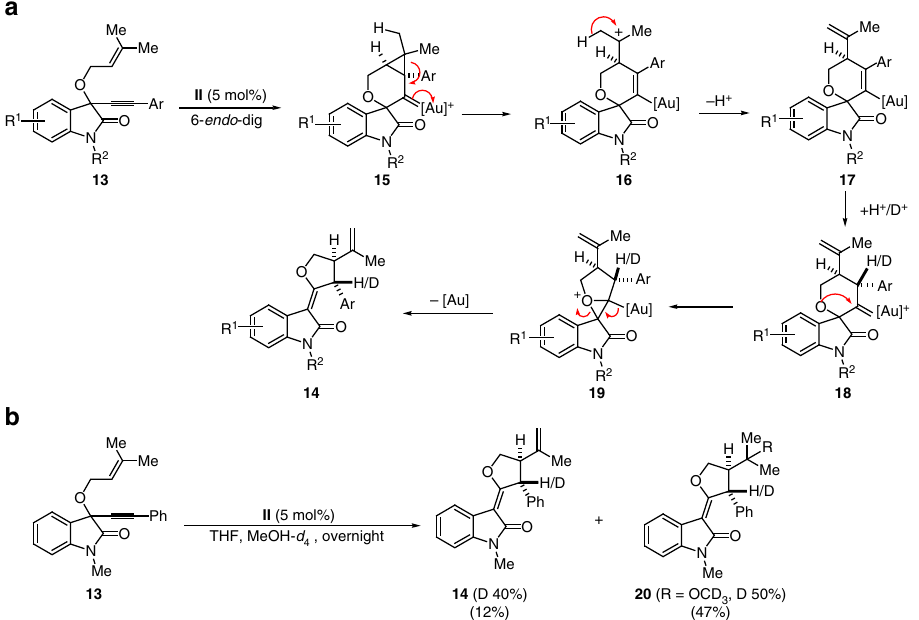
Figure 5 | Mechanistic proposal for the formation of df -oxindole 14. ( a ) The proposed mechanism of the formation of df -oxindole 14 involves the gold(I)-mediated 6- endo -dig cycloisomerization of 1,6-enyne to afford 15 , followed by subsequent deprotonation, protonation, formation of a strained tetracyclic spiro-oxenium intermediate ( 19 ) and its rearrangement to afford 14 . ( b ) In the presence of d- MeOH (as nucleophile as well as deuterium source), df- oxindole 14 and d- MeOH adduct 20 of df- oxindole was obtained in 14% yield with 40% deuteration at benzylic position and 47% yield with 50% deuteration at benzylic position, respectively. MeOH- d 4 , deuterated